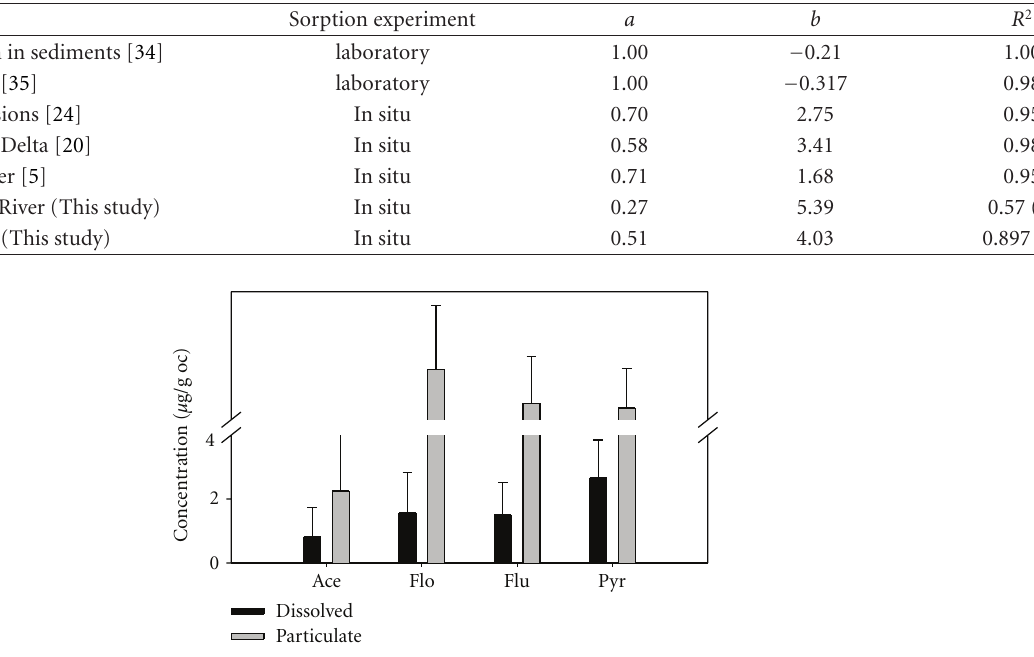
Figure 8: Organic carbon-normalized concentrations of Ace, Flo, Flu, and Pyr in the river water and the SPM